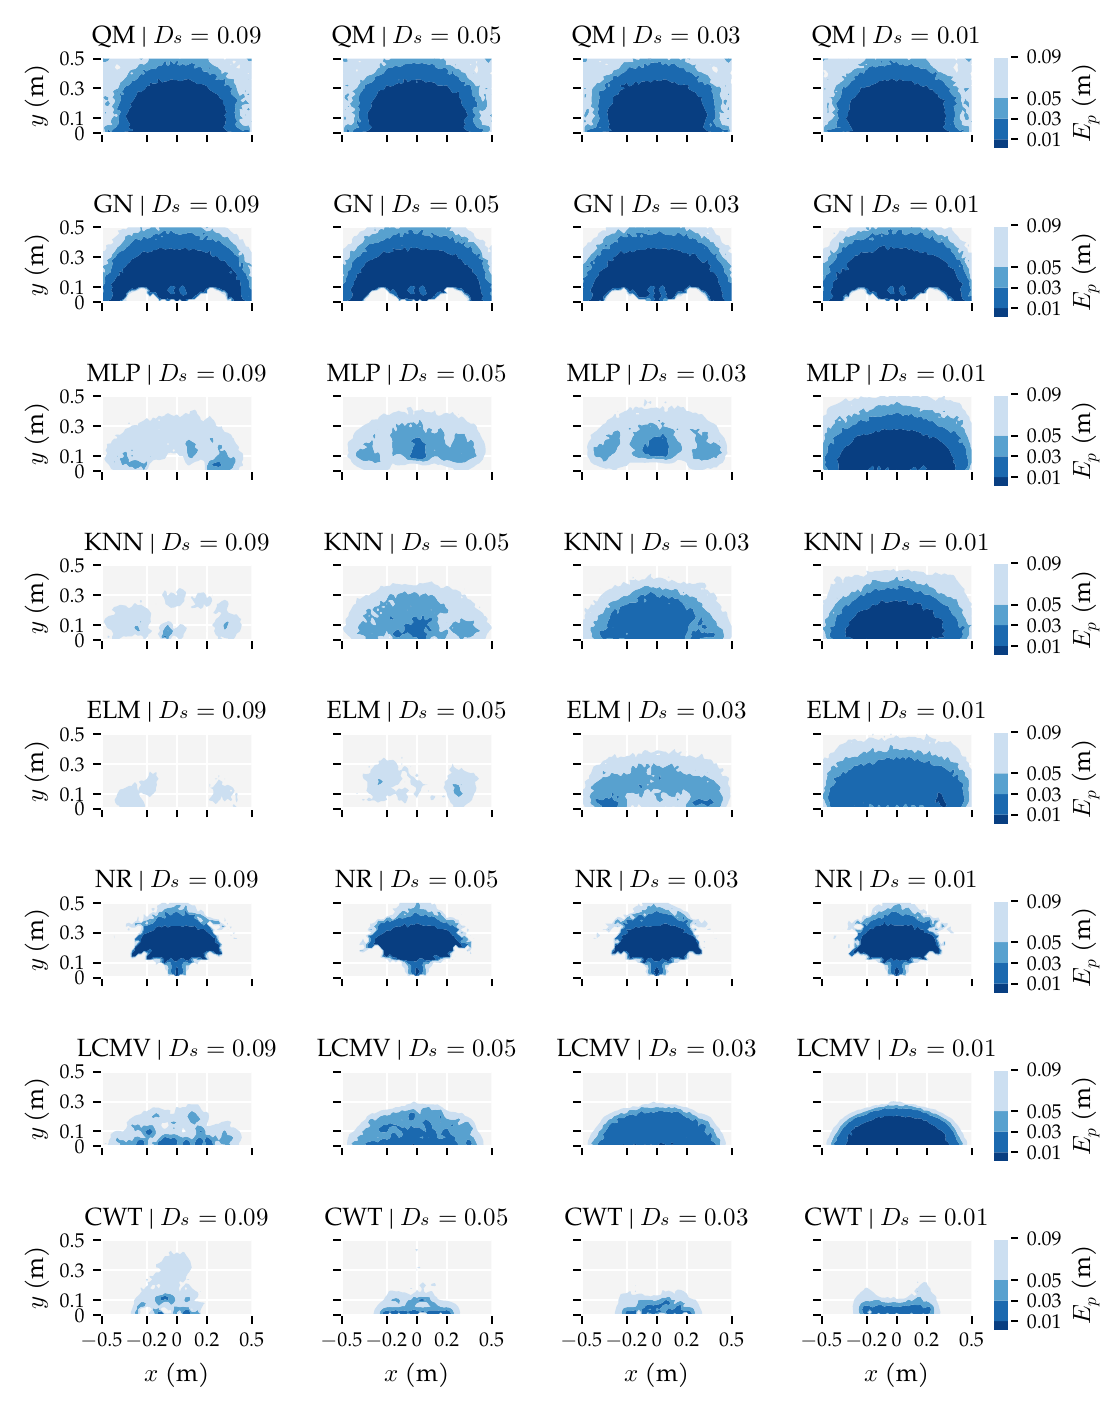
Figure A4. Spatial contours of the median position error (Equation (4)) for each localisation algorithm in all conditions of Analysis Method 1. This analysis varied the minimum distance D s between sources in the training and optimisation sets (Table 1) while using the (x + y) sensor configuration at the σ = 1 × 10 − 5 ms − 1 noise level. The median position error was computed in 2 × 2 cm 2 cells. The sensors were equidistantly placed between x = ± 0.2